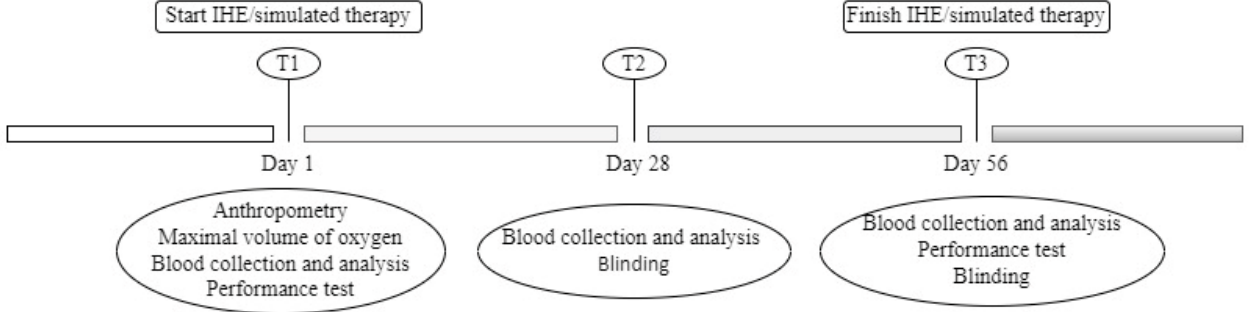
Figure 1. A descriptive diagram of the study timeline.